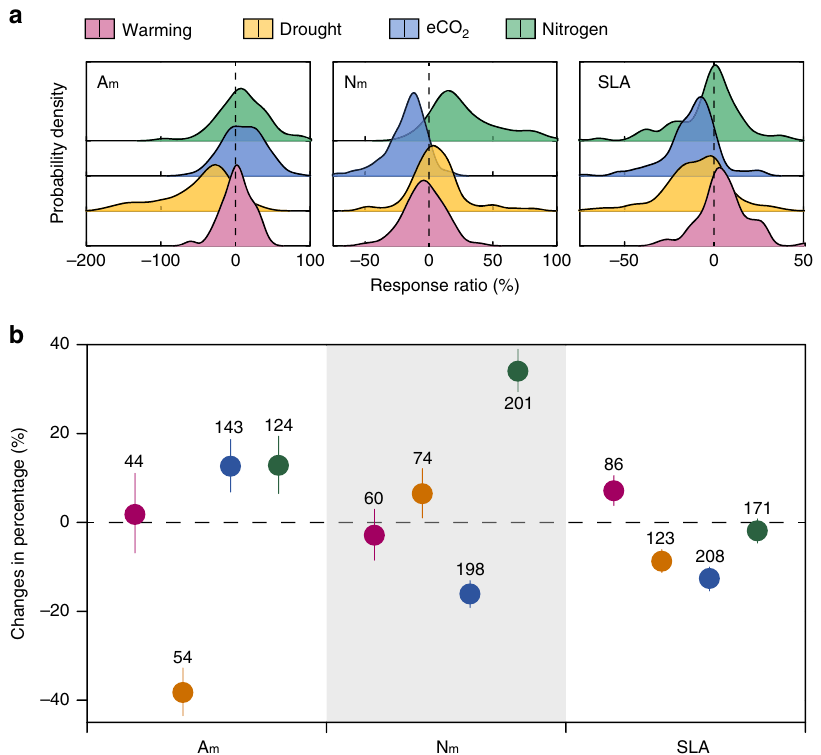
Fig. 2 Percentage changes of leaf functional traits under global environmental factors. a Probability density of response ratios of leaf traits to warming, drought, eCO 2 , and nitrogen addition. b Effects of global environmental changes on leaf functional traits. Circles represent the global mean changes, and error bars are 95% credible intervals on the mean. The horizontal dashed line indicates 0 (no effect). The number of species under treatments of warming, drought, eCO 2 , and nitrogen addition are 44, 54, 143, and 124 for A m , 60, 74, 198, and 201 for N m , and 86, 123, 208, and 171 for SLA (i.e., the numbers shown near the